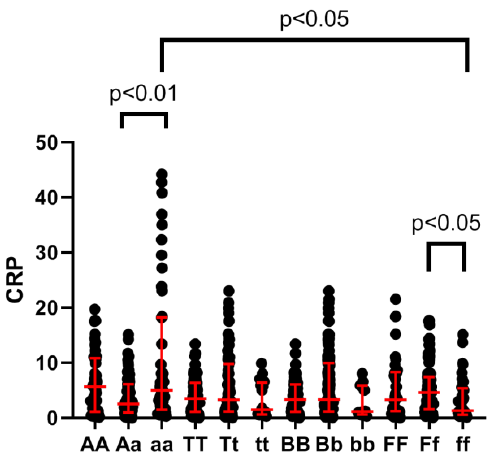
Figure 2. C–reactive protein (CRP) level and vitamin D receptor gene polymorphisms in rheumatoid arthritis patients.